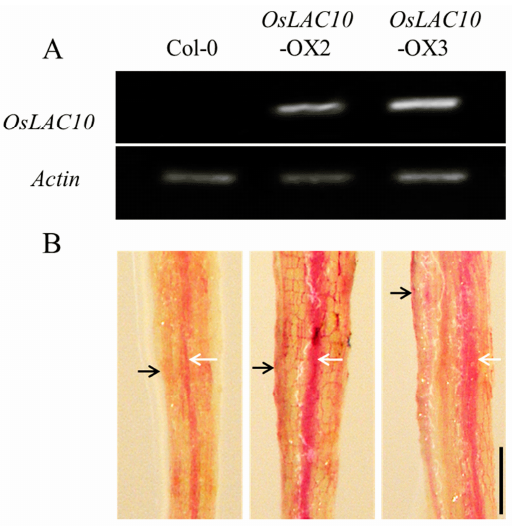
Figure 7. Transgene expression and lignin accumulation in transgenic Arabidopsis plants overexpressing OsLAC10 . ( A ) Expression levels of OsLAC10 in transgenic Arabidopsis plants; ( B ) Histochemical localization of lignin in root of wild-type and transgenic Arabidopsis . Lignified portion is red. Black and white arrows show epidermis and vascular cylinder, respectively. Black bars, 200 μ m.